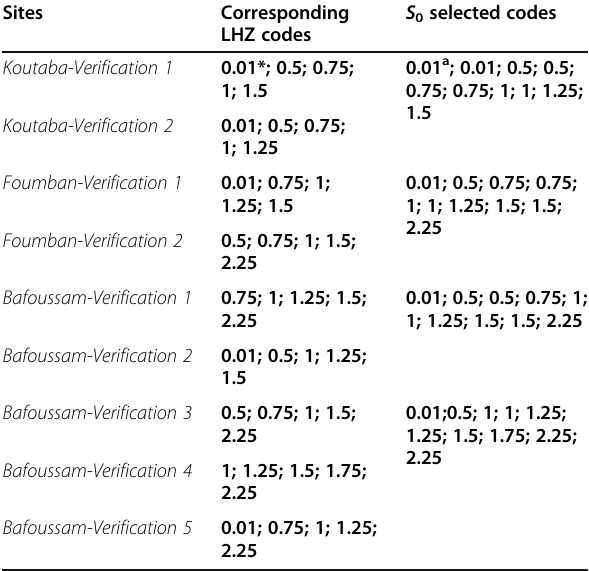
Table 8 LHZ codes matching and surrounding the verification sites Sites